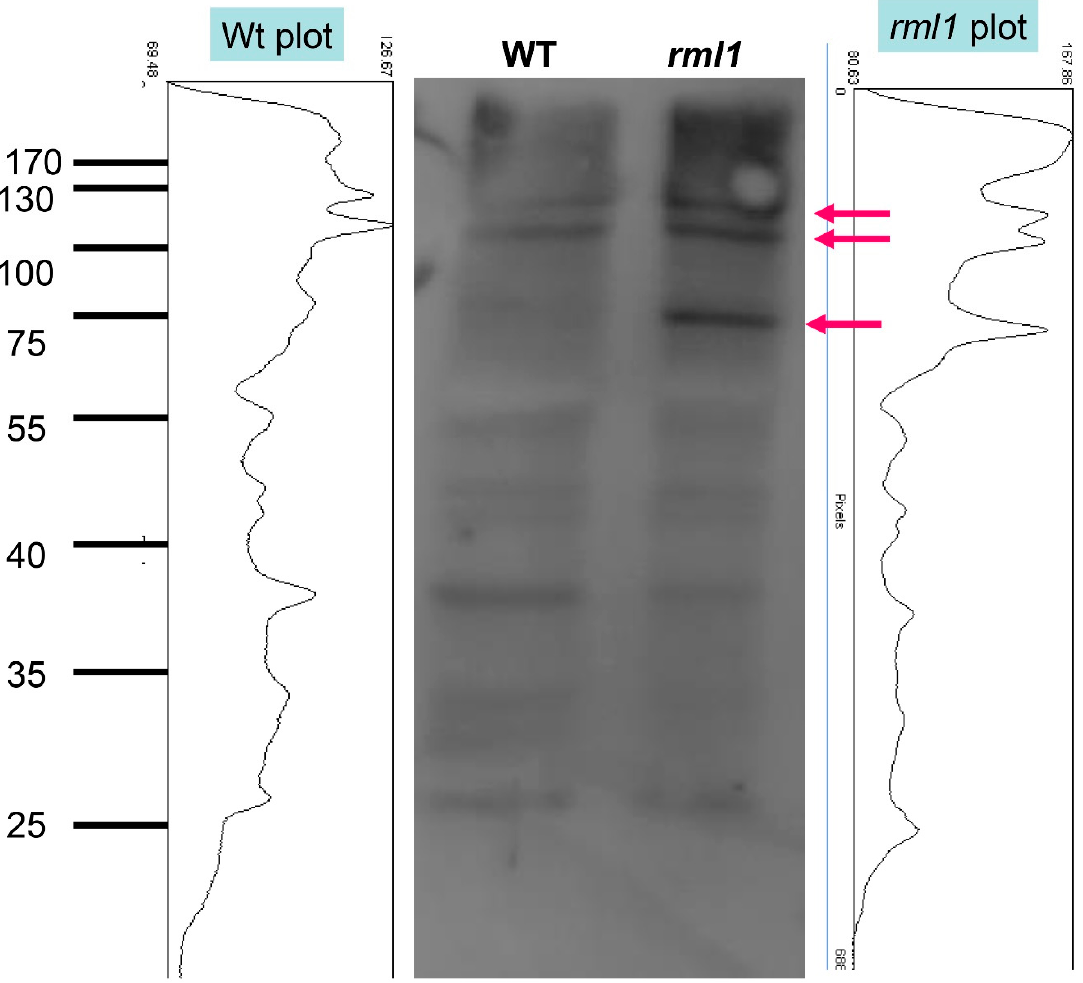
Figure 5. GSH level affects protein ubiquitination status . Protein was isolated from 4-day-old WT and homozygotic rml1 plants and subjected to immunoblotting with Ubi11 AS08 307 (Agrisera) antibody. Each lane contains 10 µg protein. Arrows show the accumulations of high MW ubiquitinated proteins in rml1 mutant.